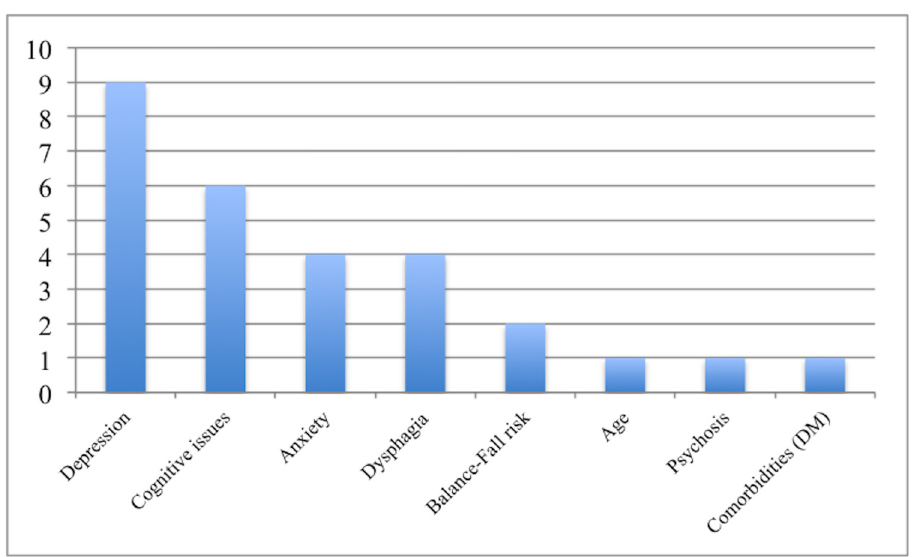
Fig 4. Issues cited as contributing to reservations reported by each service during screening.